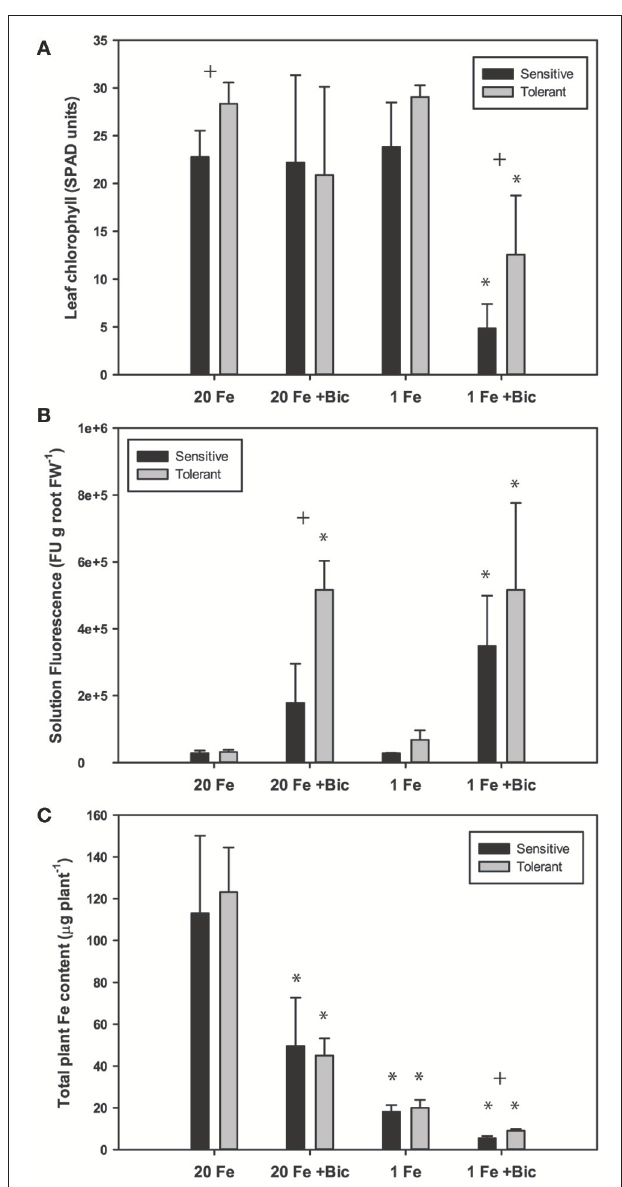
FIGURE 5 | Leaf chlorophyll, nutrient solution fluorescence, and total plant Fe accumulation in IDC tolerant and sensitive soybean plants. Plants were treated with 1 or 20 µ M FeSO 4 and 0 or 2.5mM sodium bicarbonate for 12 d. (A) leaf chlorophyll of first trifoliate leaf in SPAD units; (B) total fluorescence units of nutrient solution normalized to root FW; (C) Total plant Fe accumulation (content), in µ g Fe per plant. * indicates a significant difference ( p < 0.05) between treatment and control (20 Fe, 0 Bic). + indicates a significant difference between the tolerant and sensitive lines in that